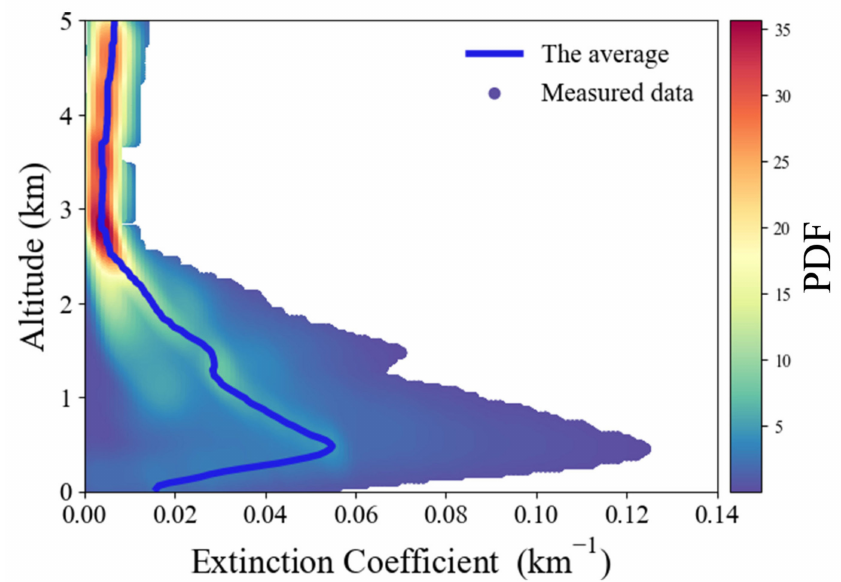
Figure 3. Typical aerosol extinction coefficient profile in the period from 8 June to 2 July 2019. The blue solid line indicates the average aerosol extinction profile, while points on the graph denote the probability density of measured data.